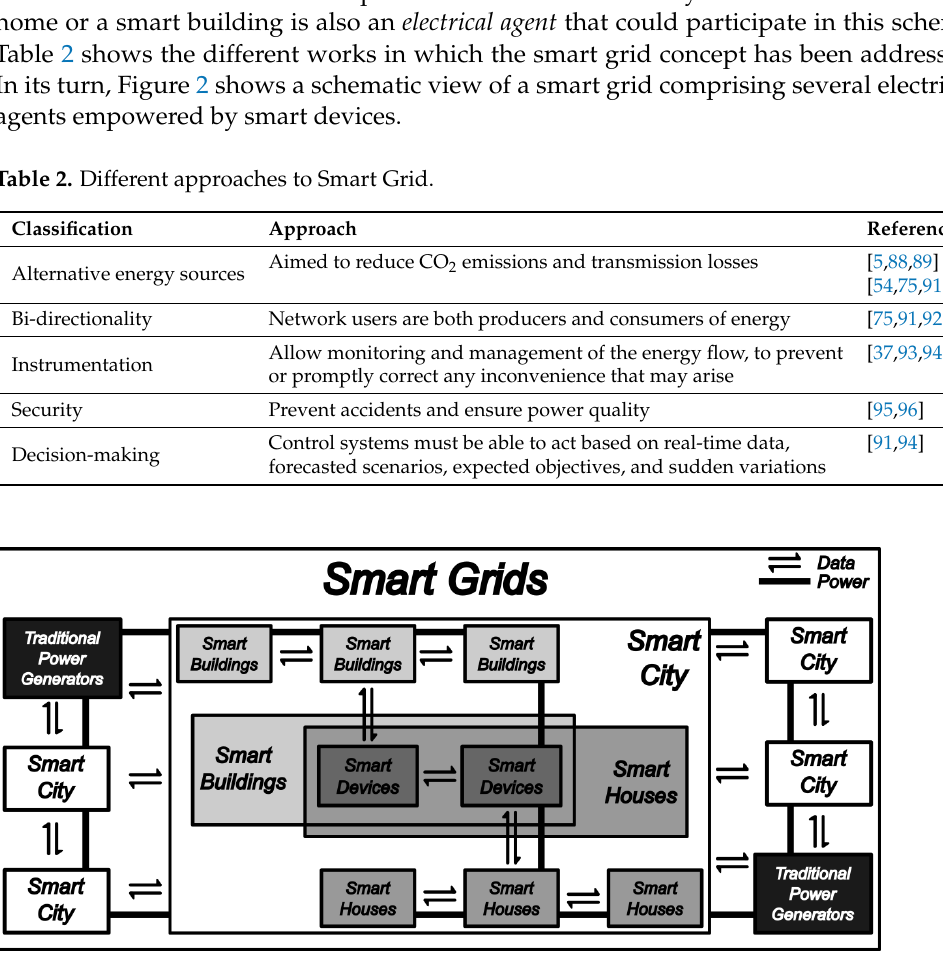
Figure 2. Systems smartification